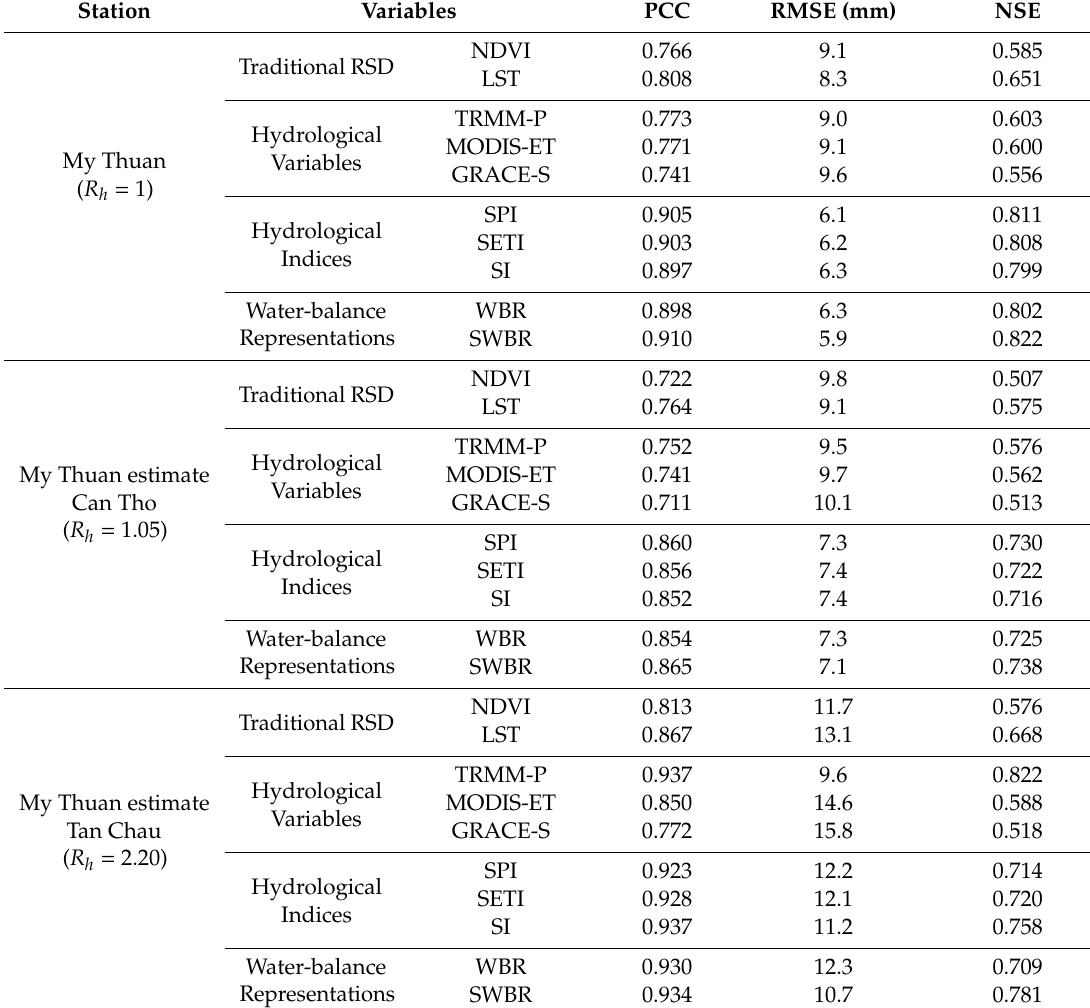
Table 2. Internal assessment of surface runo ff ( R ), reconstructed using data from My Thuan station, and external assessment of R , estimated for Can Tho and Tan Chau stations. The legend ‘My Thuan estimate Can Tho’ (or ‘Tan Chau’) means that the R for Can Tho (or Tan Chau) was estimated based on the reconstructed relationships between the R from My Thuan station and the abovementioned